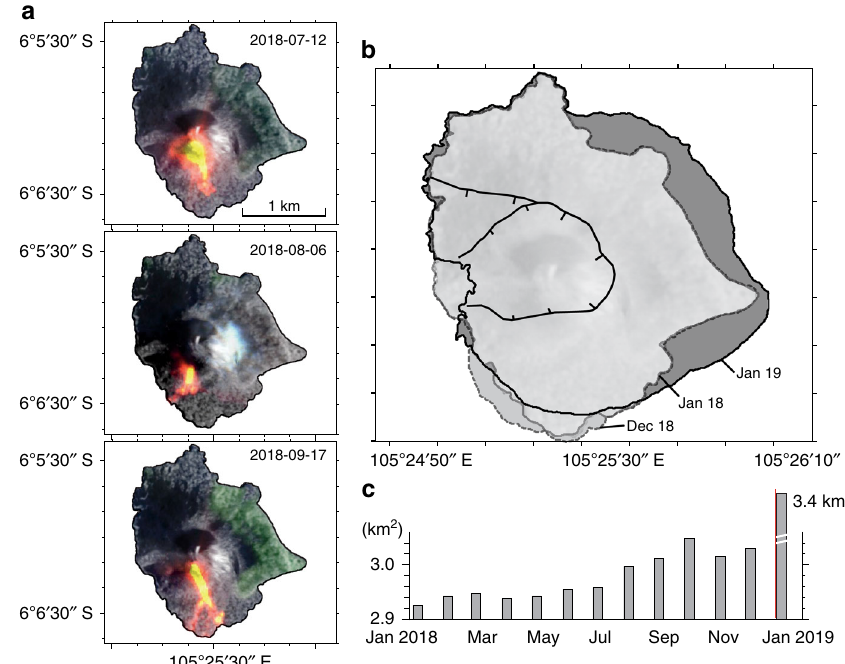
Fig. 2 Eruptions and island perimeter growth map. a Several selected Sentinel-2 images (band combination of 12, 11, 4) showing the emplacement of hot and new material (red-yellow) on the southern fl ank of Anak Krakatau during the increased eruptive activity in 2018 (see also Supplementary Figure 1). b Island perimeter maps derived from satellite radar amplitude images (Supplementary Figure 2) show little variation from January 2018 to June 2018, followed by southward growth from June 2018 to December 2018 prior to the sector collapse (light gray). The black lines indicate the new scarps formed by the sector collapse. The outer outline indicates the postcollapse island perimeter in January 2019 (dark gray). c Land area change based on monthly island perimeter analysis. The area changed gradually prior to the fl ank collapse, but more rapidly after the collapse event. Maps created using the